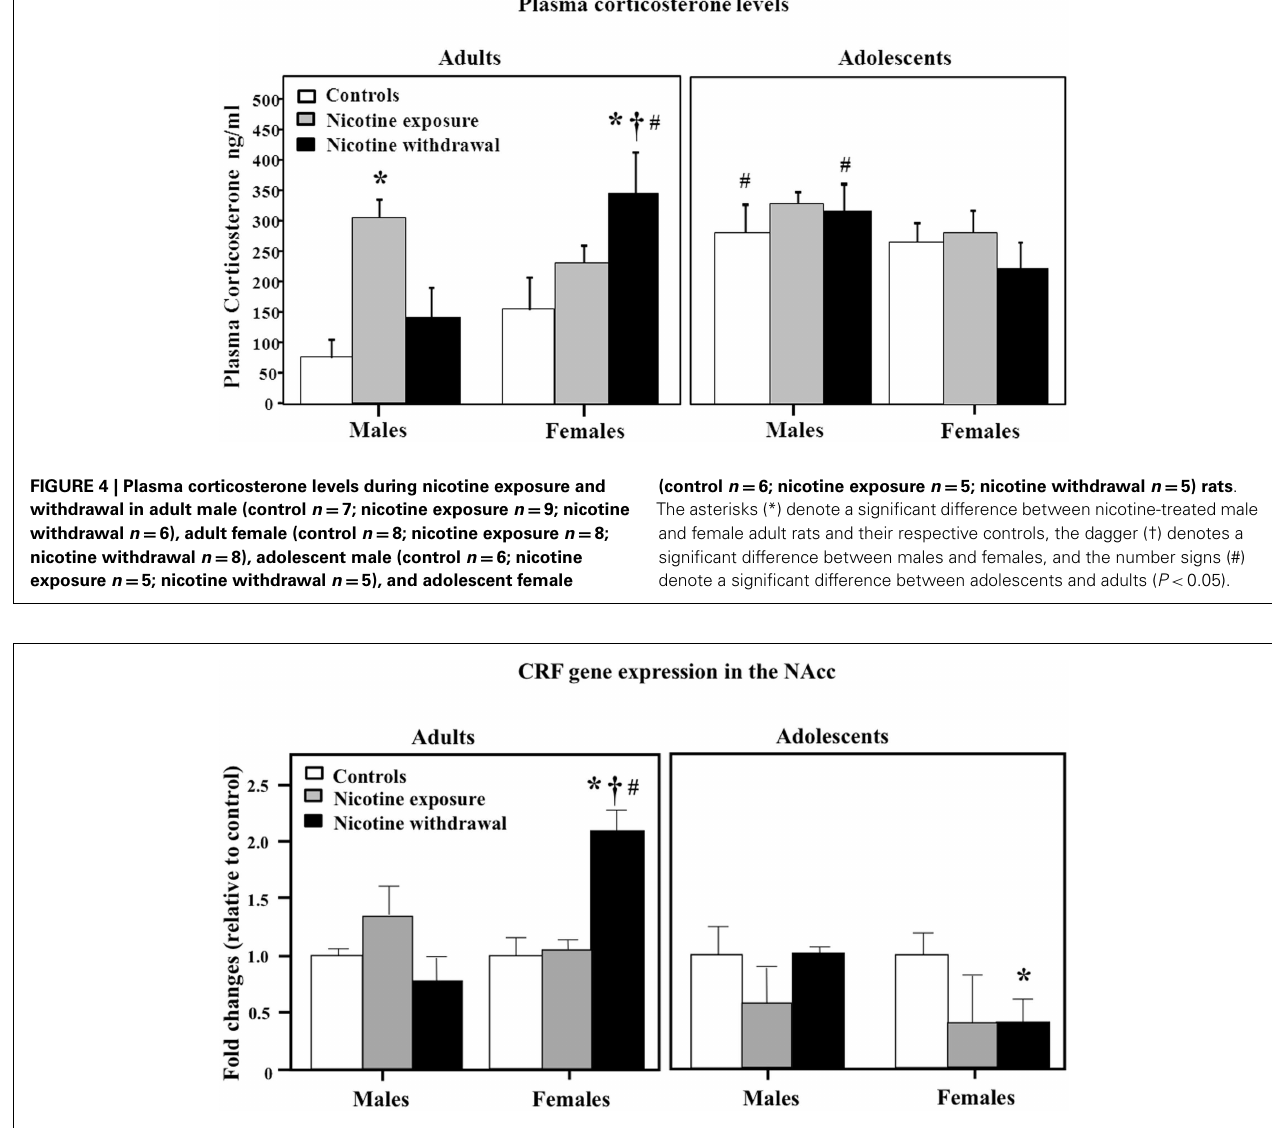
FIGURE 5 | CRF gene expression in the NAcc during nicotine exposure and withdrawal in adult male (control n = 4; nicotine exposure n = 4; nicotine withdrawal n = 4), adult female (control n = 4; nicotine exposure n = 4; nicotine withdrawal n = 4), adolescent male (control n = 6; nicotine exposure n = 5; nicotine withdrawal n = 5), and adolescent female